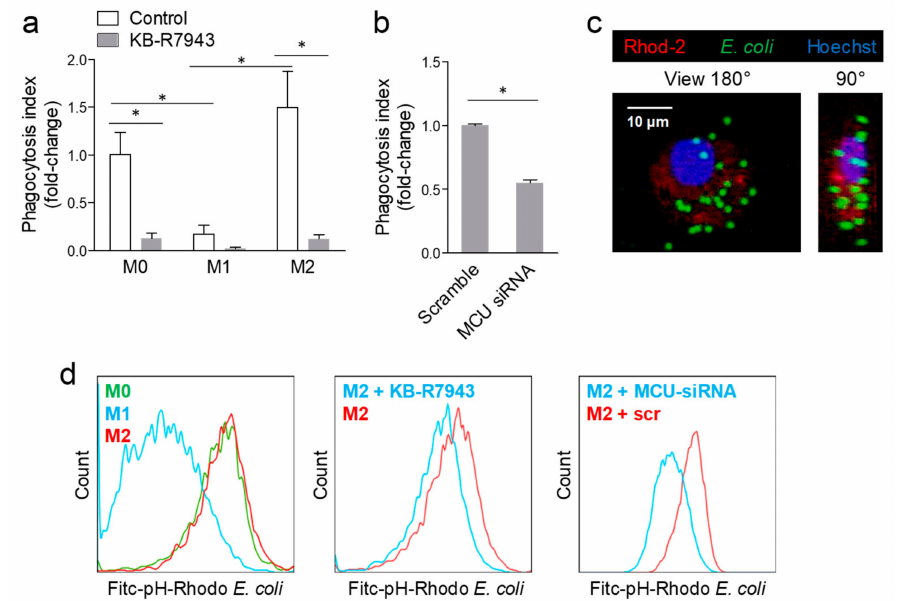
Figure 4. Blocking MCU inhibited phagocytosis. ( a ) Phagocytosis of E. coli fragments was quantified using flow cytometry in resting (M0), M1- and M2-polarized macrophages in the control condition or after pre-treatment with the MCU inhibitor KB-R7943 (* p < 0.05 after 2-way ANOVA). ( b ) Phagocytosis of E. coli fragments was quantified in M2-polarized macrophages transfected with scramble siRNA, or siRNA against MCU (* p < 0.05). ( c ) Representative 3D reconstruction of z-stacks collected during live imaging of M2 macrophages with confocal multiphoton multicolour microscopy. Cells were stained with the mitochondrial red calcium dye Rhod-2, the nuclear dye Hoechst 33342, while the green fluorescence derives from E. coli fragments (pH-Rhodo). The 180 ◦ and 90 ◦ rotated images are shown. ( d ) Representative FACS histograms showing phagocytic capacity of resting (M0), M1- and M2-polarized macrophages, as well as the e ff ects of the MCU inhibitor KB-R7943 or MCU silencing on phagocytosis by M2 macrophages. The histogram shows, for each condition, the fluorescence intensity of the green (Fitc) channel on the x -axis, relative to the normalized cell count on the y